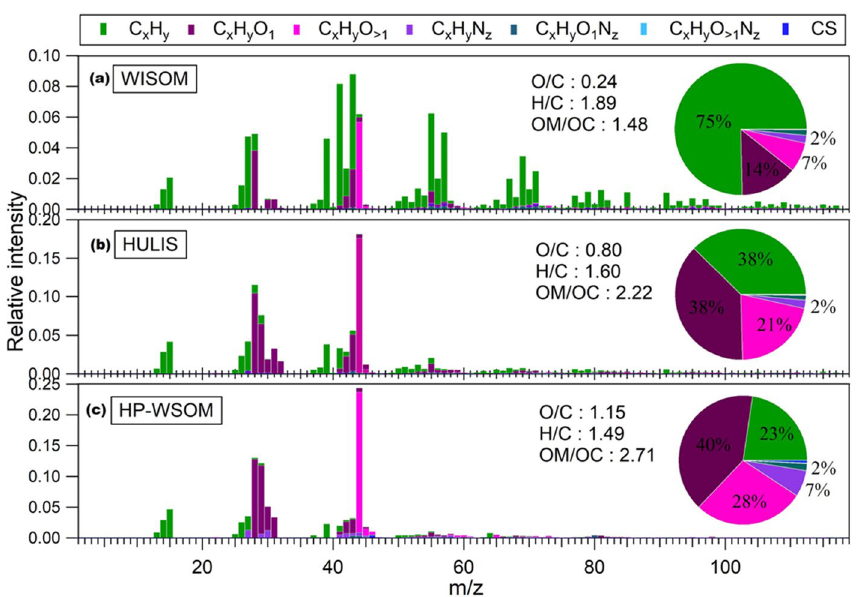
Figure 3. Normalized HR-AMS spectra of ( a ) WISOM, ( b ) HULIS, and ( c ) HP-WSOM. The pie charts represent the mean percentages of the ion groups in the spectra of the OA